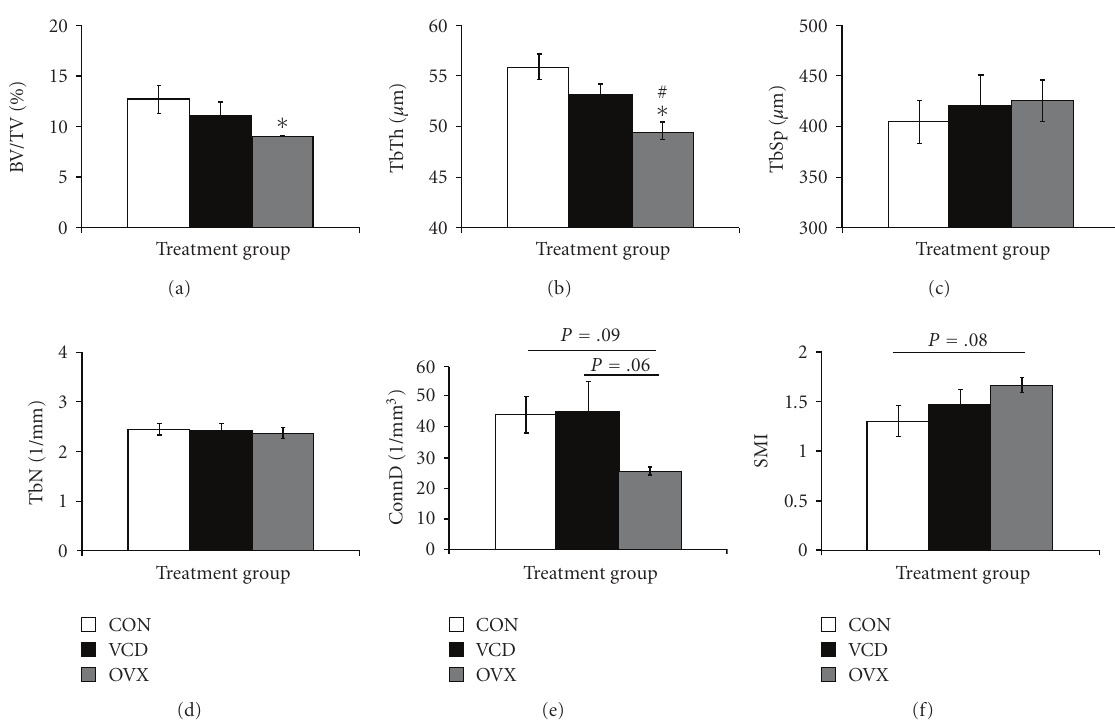
Figure 2: Trabecular microarchitecture in aged VCD-treated and ovariectomized mice. Aged C57BL/6Hsd female mice (9–12 months old) were dosed daily for 15 days with sesame oil (vehicle; CON) or VCD (160mg/kg) or were ovariectomized on d35 after the start of the experiment. Trabecular bone microarchitecture of the fifth vertebral body was assessed by μ CT on samples collected at 5-month postovarian failure (age: 18.8 months; d181) as described in Section 2. Data are represented as mean ± SEM ( n = 4–6). Significance was set at P < . 05. The following variables were measured: bone volume fraction (BV/TV%), trabecular thickness (TbTh, μ m), trabecular separation (TbSp, μ m), trabecular number (TbN, 1/mm), connectivity density (ConnD, 1/mm 3 ), and structure model index (SMI). ( ∗ ) indicates P < . 05 versus CON; (#) indicates P < . 05 versus VCD. Trends are represented by bars indicating the corresponding P -value.